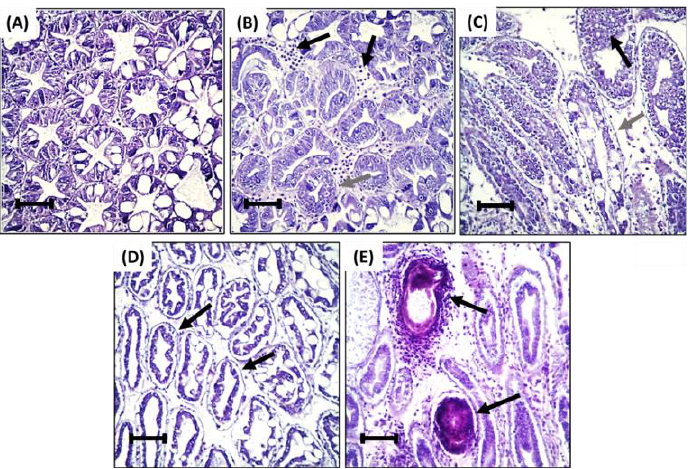
Figure 2. Representative histopathological findings from: ( A ) Normal hepatopancreatic tubule of negative control group. ( B ) Hepatopancreatic tubule of shrimp fed with 0.1% HDPE-MP with hemocyte between interstitial tissue of hepatopancreas (black arrow) and epithelium hyperplasia (gray arrow). ( C ) Hepatopancreatic tubule of shrimp fed with 0.5% HDPE-MP with epithelium hyperplasia (black arrow), epithelium detachment, and deformation of hepatopancreatic tubule (gray arrow). ( D ) Hepatopancreatic tubule of shrimp fed with 1% HDPE-MP with pronounced epithelium detachment and deformation of hepatopancreatic tubule (black arrow). ( E ) Hepatopancreatic tubule of shrimp fed with 3% HDPE-MP with nodule formation and melanization (black arrow). H&E staining, bar = 100 µm.